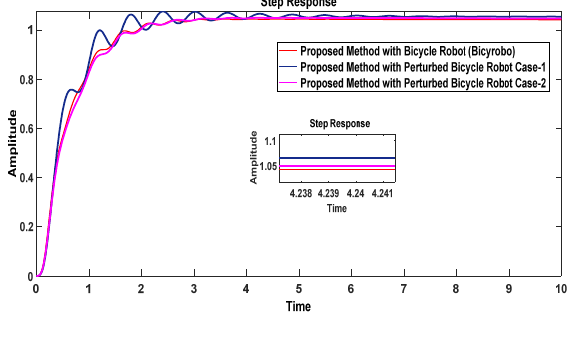
Figure 6. Time response of bicyrobo with reduced third order controllers Table 5: Performance comparison of closed-loop bicyrobo using third-order controllers Authors by